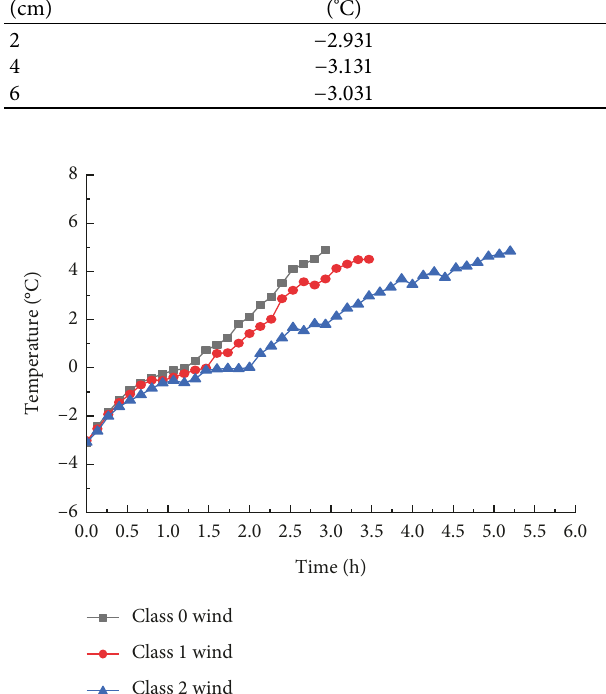
Table 8: Rates of the temperature increase of the specimen surface with different snow thicknesses. Snow thickness